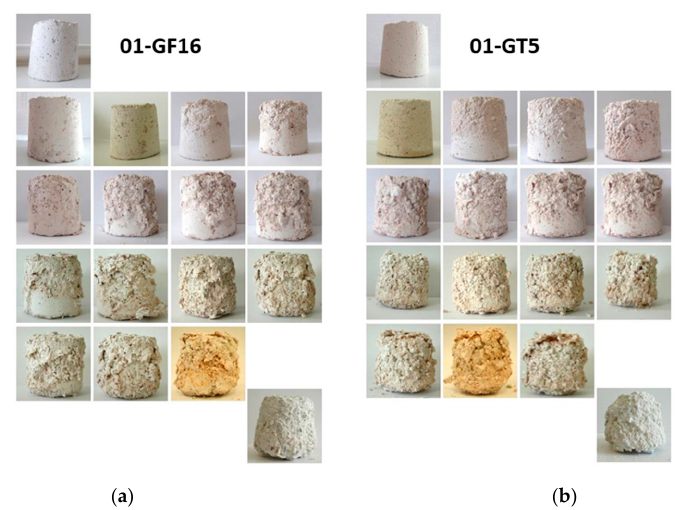
Figure 13. Photographical documentation of the deterioration of specimens ( a ) 01-GF16 and ( b ) 01-GT5 during the 15 cycles of salt crystallization. Table 10. Average value of percentage weight loss among the sound specimen and the specimen in the end of 15 cycles of salt crystallization.